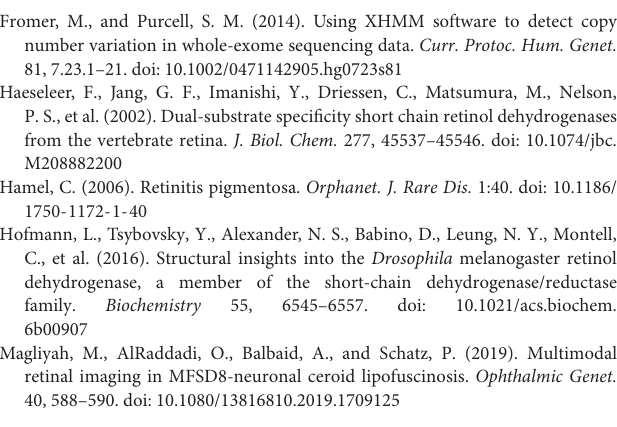
Supplementary Figure 1 | Structure modeling of wild-type and mutated RDH12. Supplementary Figure 2 | Result of SOSUI prediction to mutated RDH12. Supplementary Table 1 | The primers for sanger